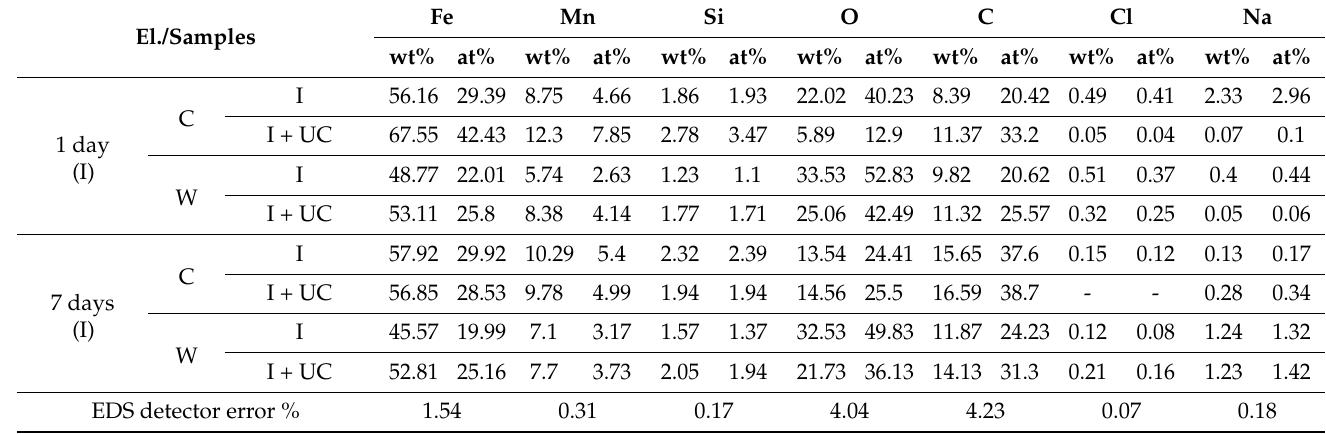
EDS detector error %